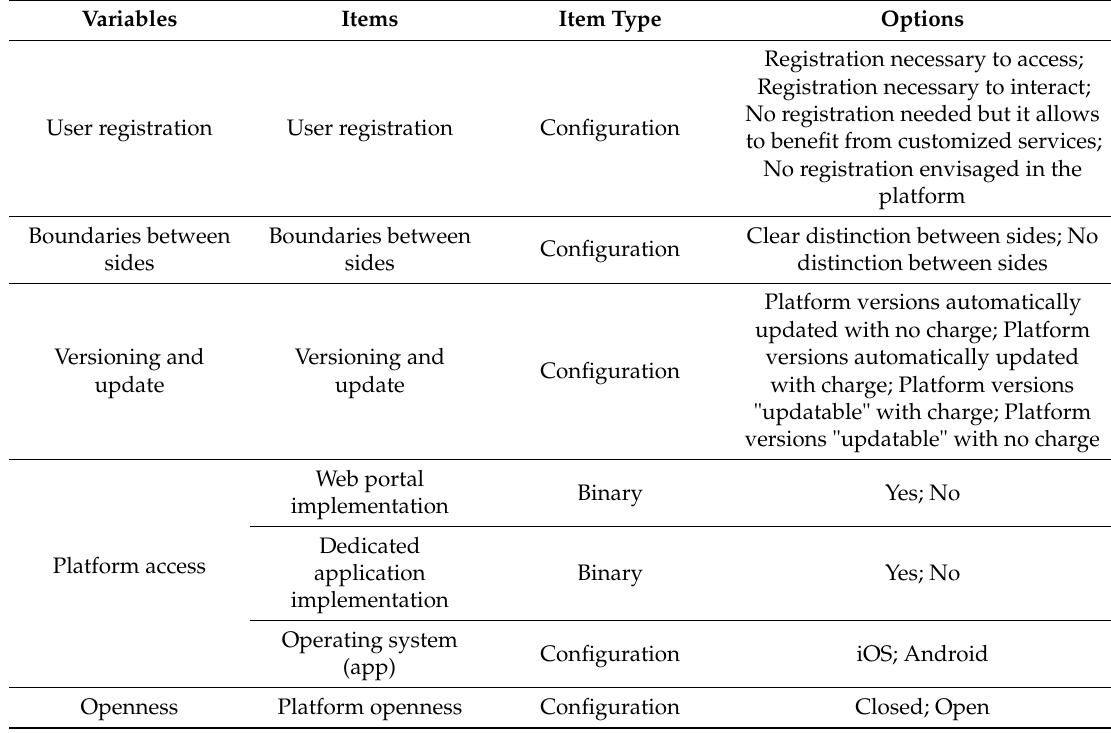
Table 10. Variables, items and configuration options for the “platform architecture”